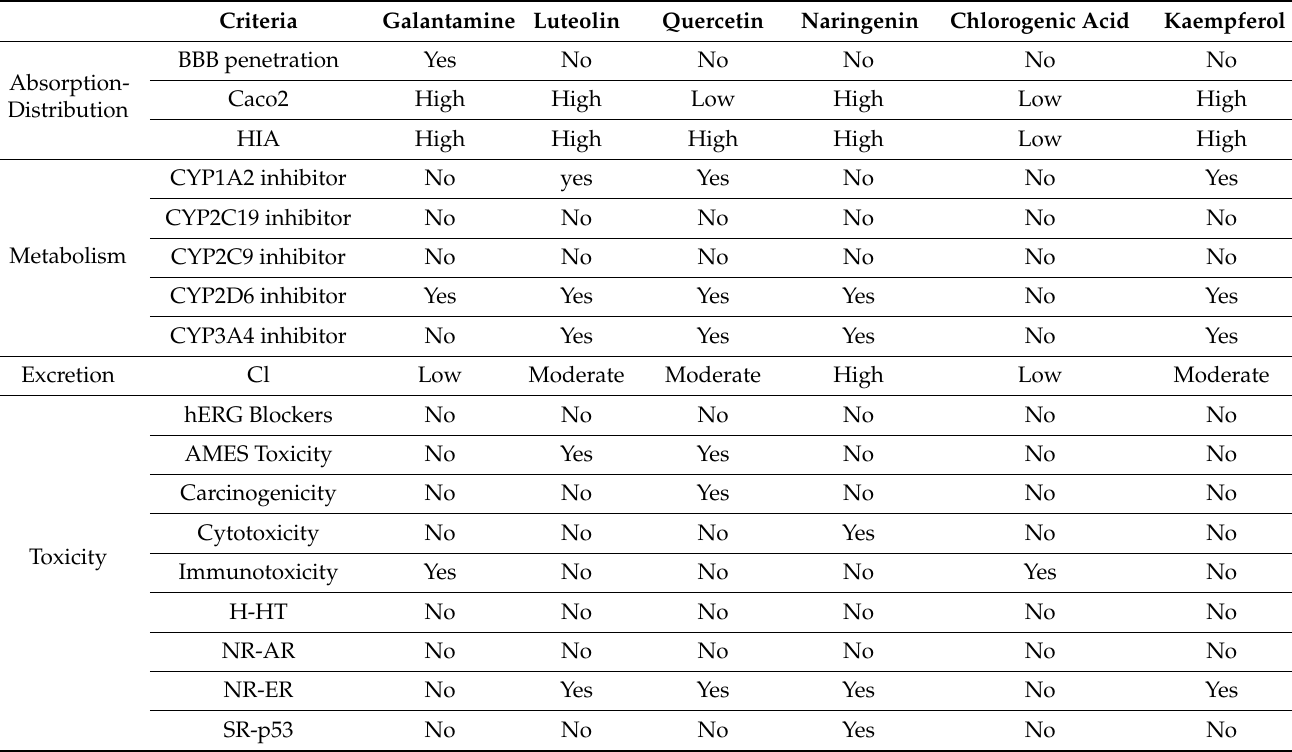
Table 6. Drug-like properties of the top active ligands of